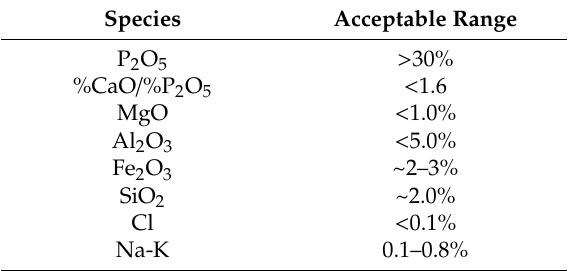
Table 2. Composition constraints for a commercial phosphate concentrate